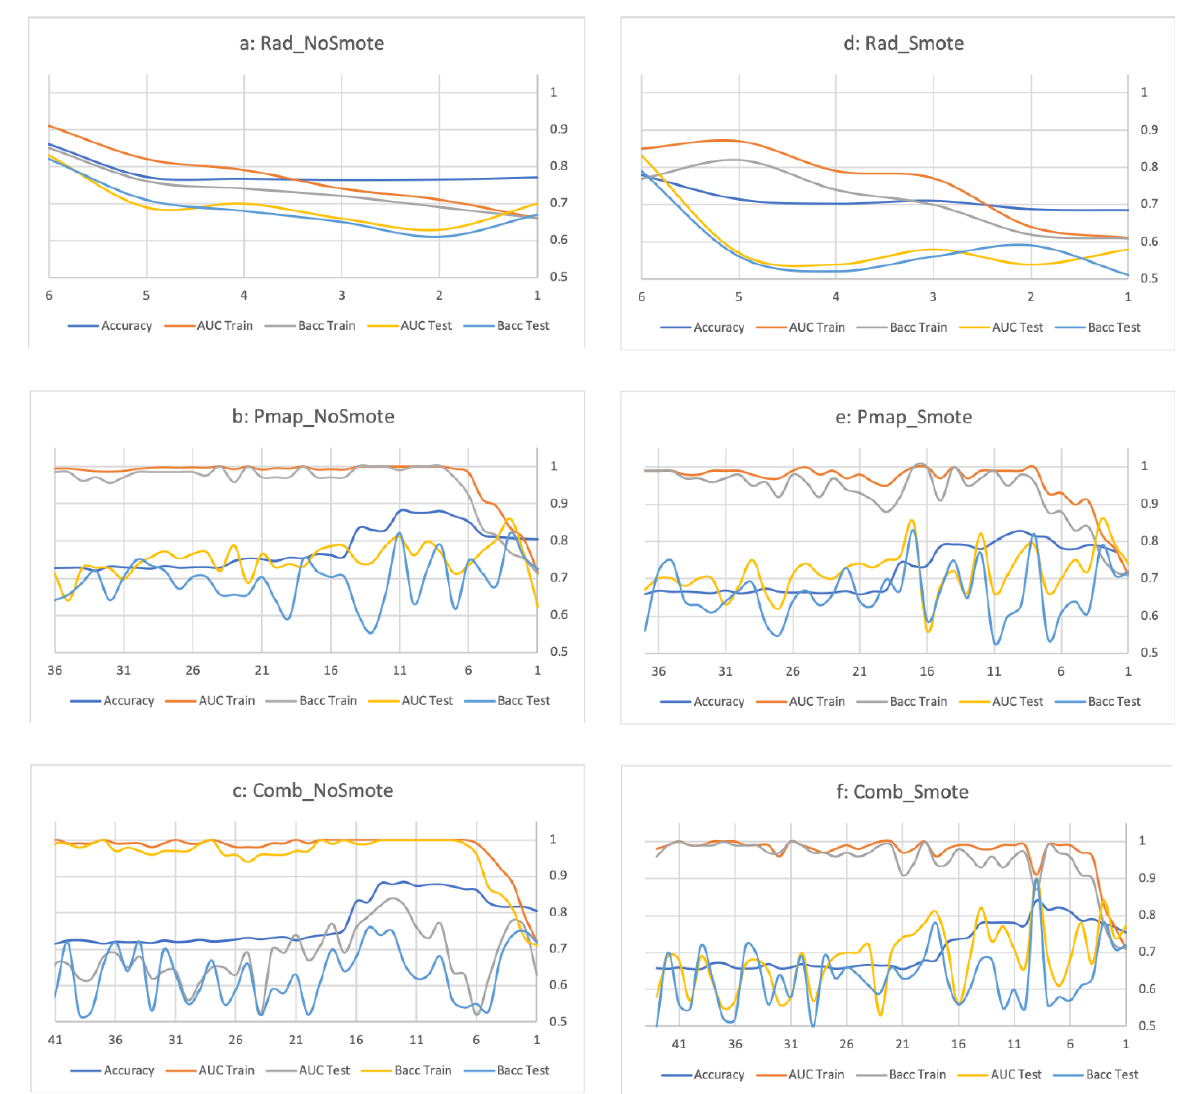
Figure 1. Performance of each model (Rad NoSmote ( a ), Rad Smote ( b ), Pmap NoSmote ( c ), Pmap Smot ( d ), Comb NoSmote ( e ), and Comb Smote ( f )) according to the number of retained features for the prediction of APT ≥ grade 2. Abbreviation: Accuracy: Mean accuracy based on the bootstrap n = 1000 replica- tions, APT: Acute pulmonary toxicity, Rad_NoSmote: Radiomics model without Smote, Rad_Smote: Radiomics model with Smote, Pmap_NoSmote: Pmap model without Smote, Pmap_Smote: Pmap